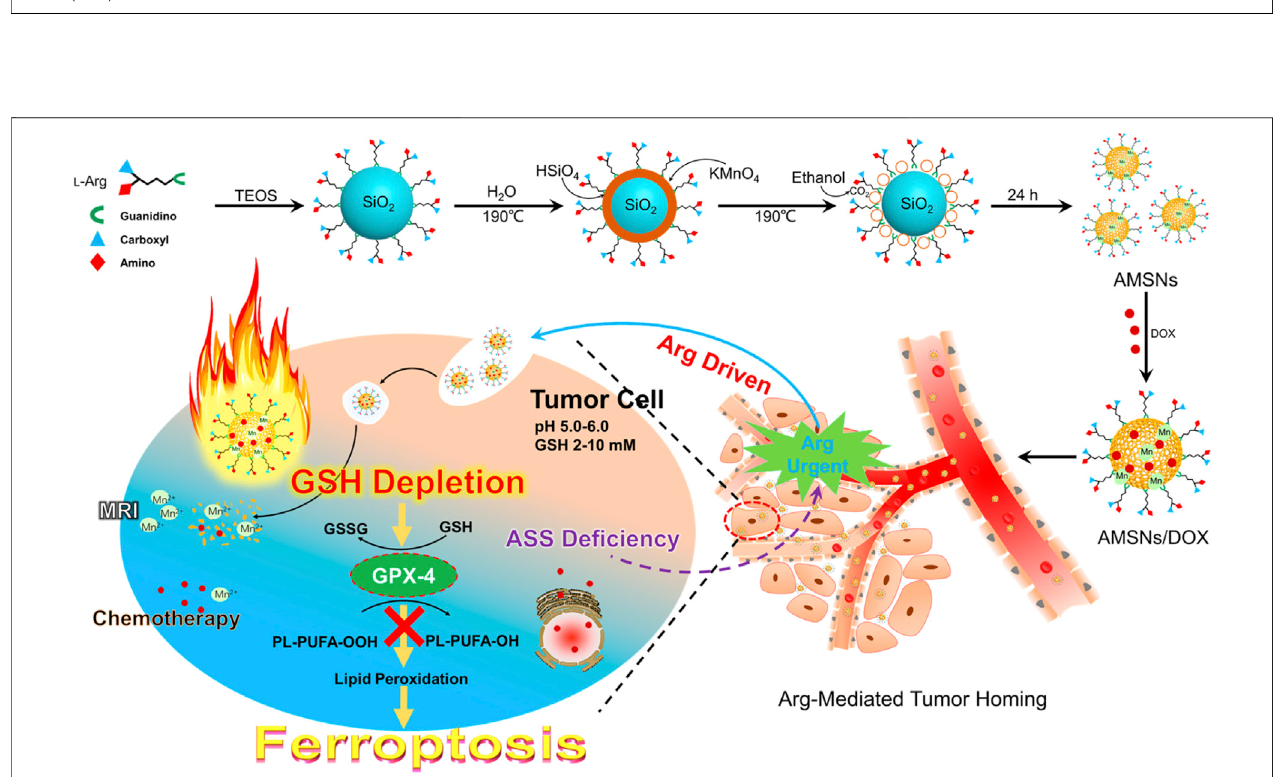
Frontiers in Chemistry |